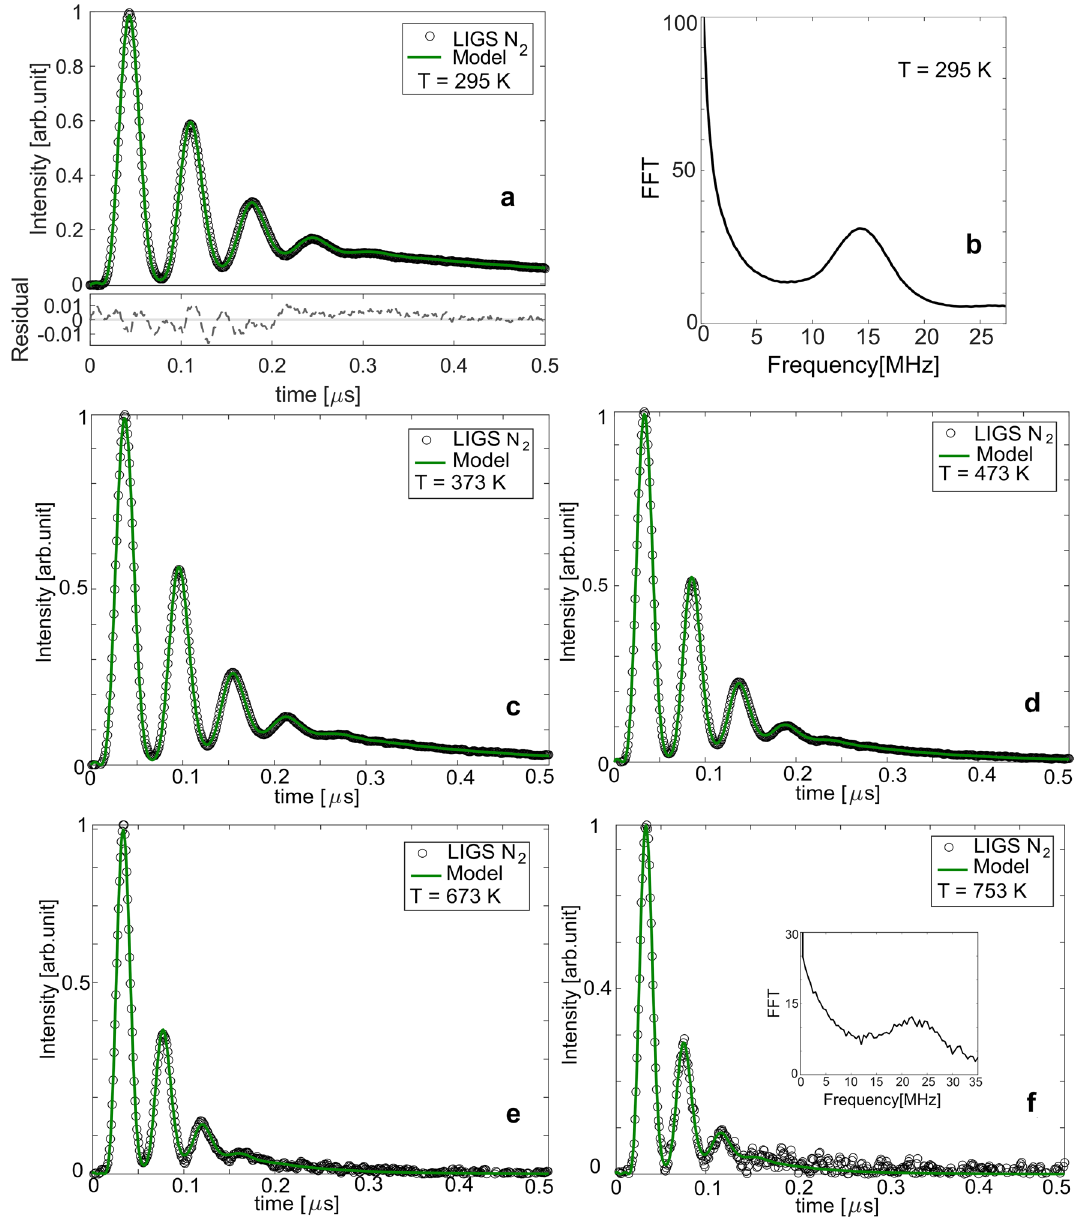
Figure 7. LITGS signals recorded in N 2 gas flow at five different temperatures at 700 µ J laser pulse energy. The different panels correspond to signals recorded at ( a ) 295 K, ( c ) 373 K, ( d ) 473 K, ( e ) 673 K, and ( f ) 753 K. ( b ) Fourier transform of the LITGS signal in ( a ) for 295